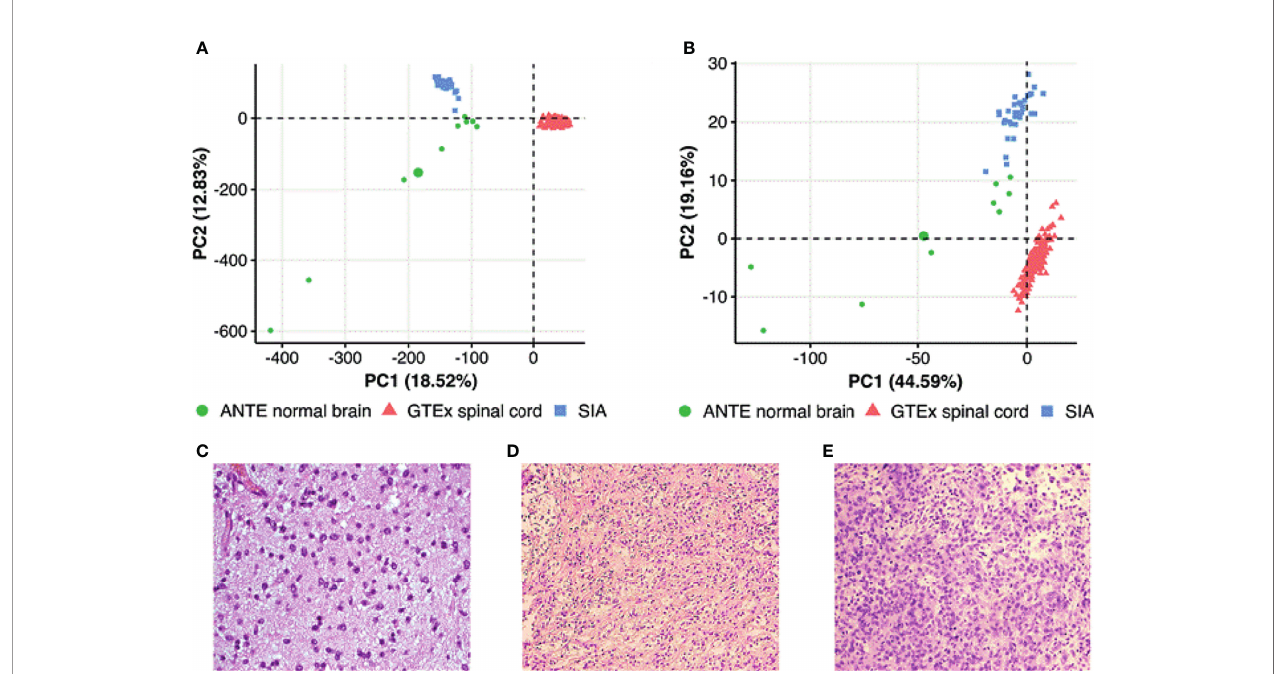
FIGURE 1 | Principal component analysis (PCA) of (A) gene expression and (B) pathway activation levels (PALs) for spinal intramedullary astrocytoma (SIA) tissue samples and publicly available spinal cord and brain normal samples from The Genotype-Tissue Expression (GTEx) Portal and Atlas of Normal Tissue Expression (ANTE). PALs were calculated according to Borisov et al. (12) with the 168 healthy CNS tissue samples taken as the controls for SIA. Histological examples of (C) a diffuse, (D) a pilocytic, and (E) an anaplastic